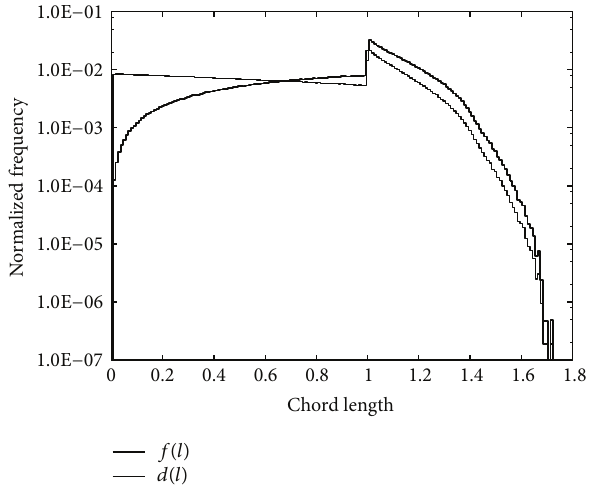
Figure 1: 𝑓(𝑙) and 𝑑(𝑙) distributions for a rectangular parallelepiped with relative dimensions 1 × 1 × 1 .